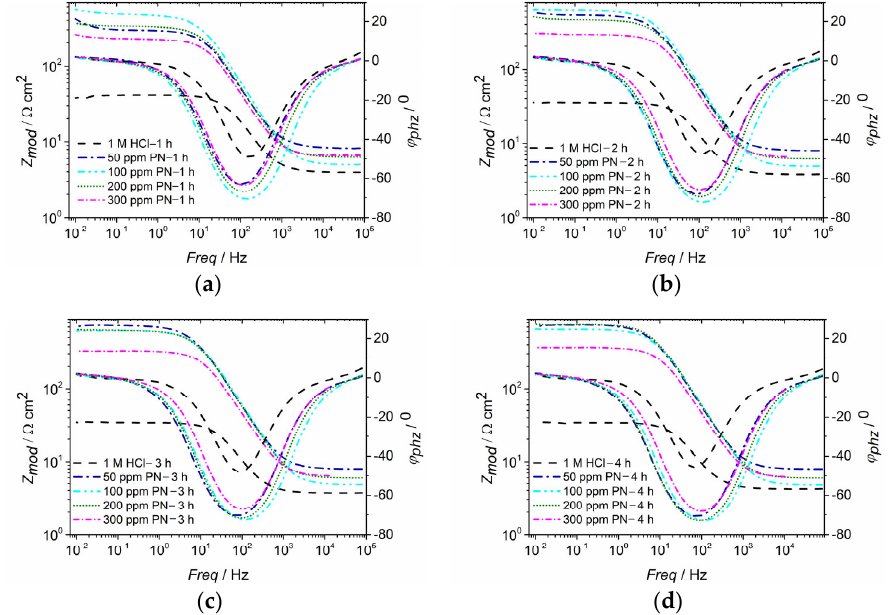
Figure 4. Bode diagrams for carbon steel in 1 M HCl solution in the absence and presence of PN inhibitor in different concentrations after: ( a ) 1 h; ( b ) 2 h; ( c ) 3 h; ( d ) 4 h immersion time.